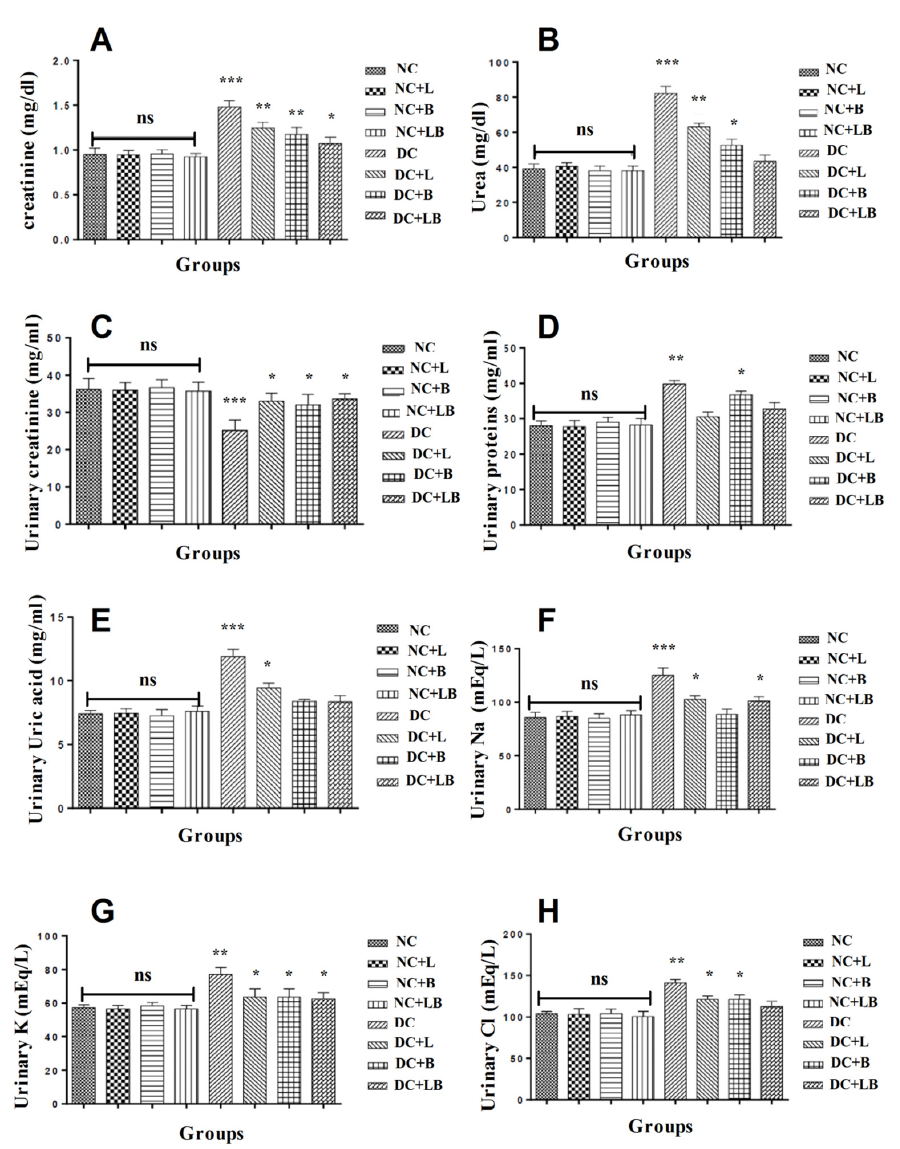
Figure 3. Impact of the daily administration of leaf and bud extracts and their combination on serum and urinary kidney parameters: ( A ) serum creatinine levels; ( B ) serum urea levels; ( C ) urinary creatinine levels; ( D ) urinary protein levels; ( E ) urinary uric acid levels; ( F ) urinary sodium levels; ( G ) urinary potassium levels; ( H ) urinary chloride levels of different groups. Data are presented as mean ± SD; (*) comparison between the normal control group (NC) and all remaining groups. (The significance started at: * p < 0.05; ** p < 0.01; *** p <